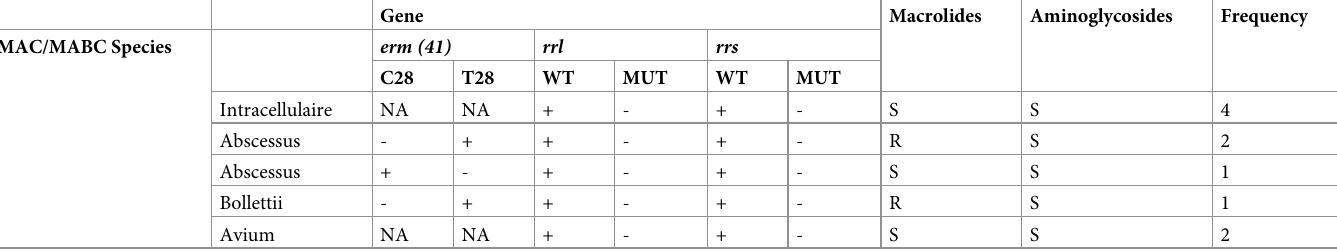
Table 2. Summary wild type bands and associated mutations in the GenoType 1 Mycobacterium NTM-DR